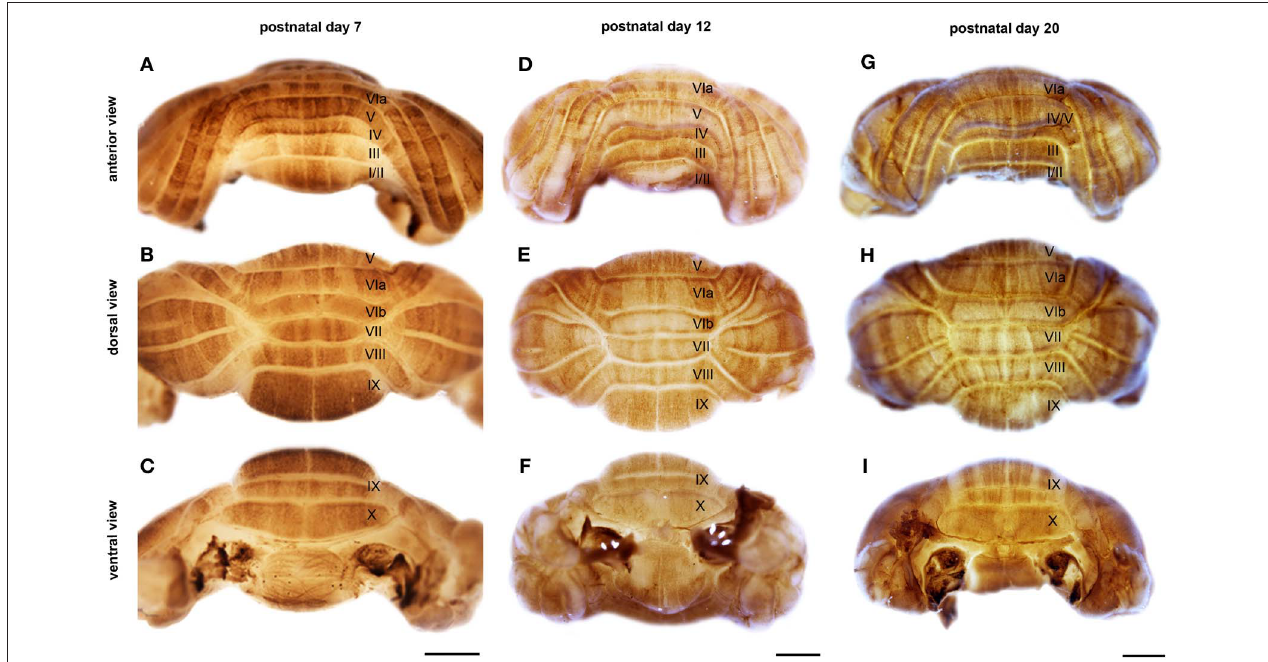
FIGURE 3 | NFH is expressed in zones throughout postnatal development. Wholemount immunohistochemistry demonstrates that NFH is expressed in zones of Purkinje cells at P7 (A–C) , P12 (D–F) , and P20 (G–I) .